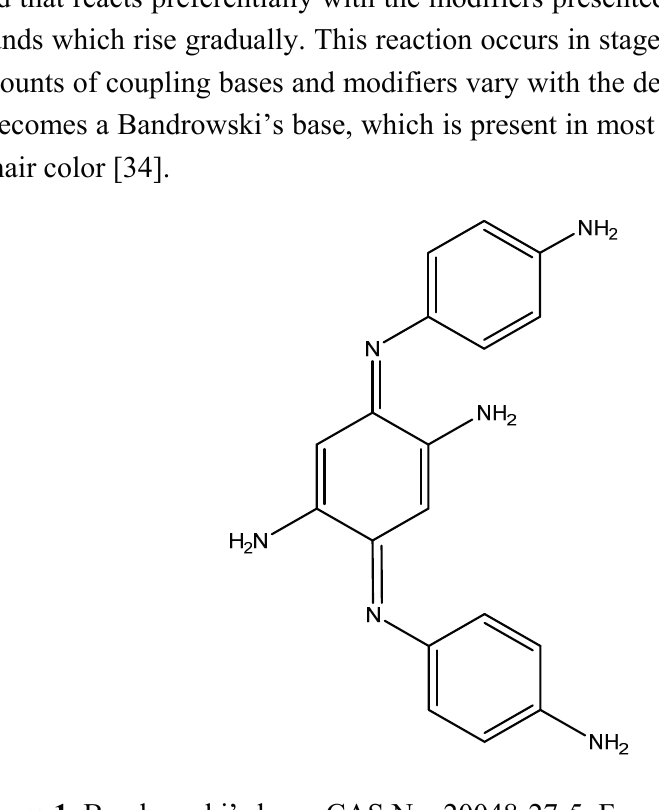
Figure 1. Bandrowski’s base. CAS No. 20048-27-5. Formula: C 18 H 18 N 6